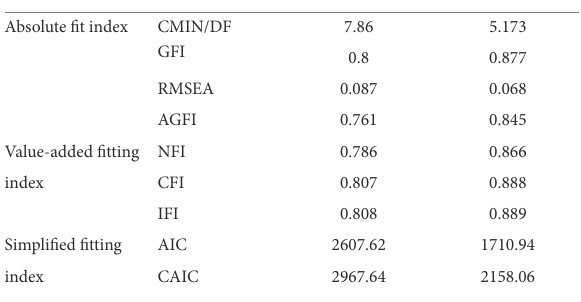
TABLE 4 Model fit index.